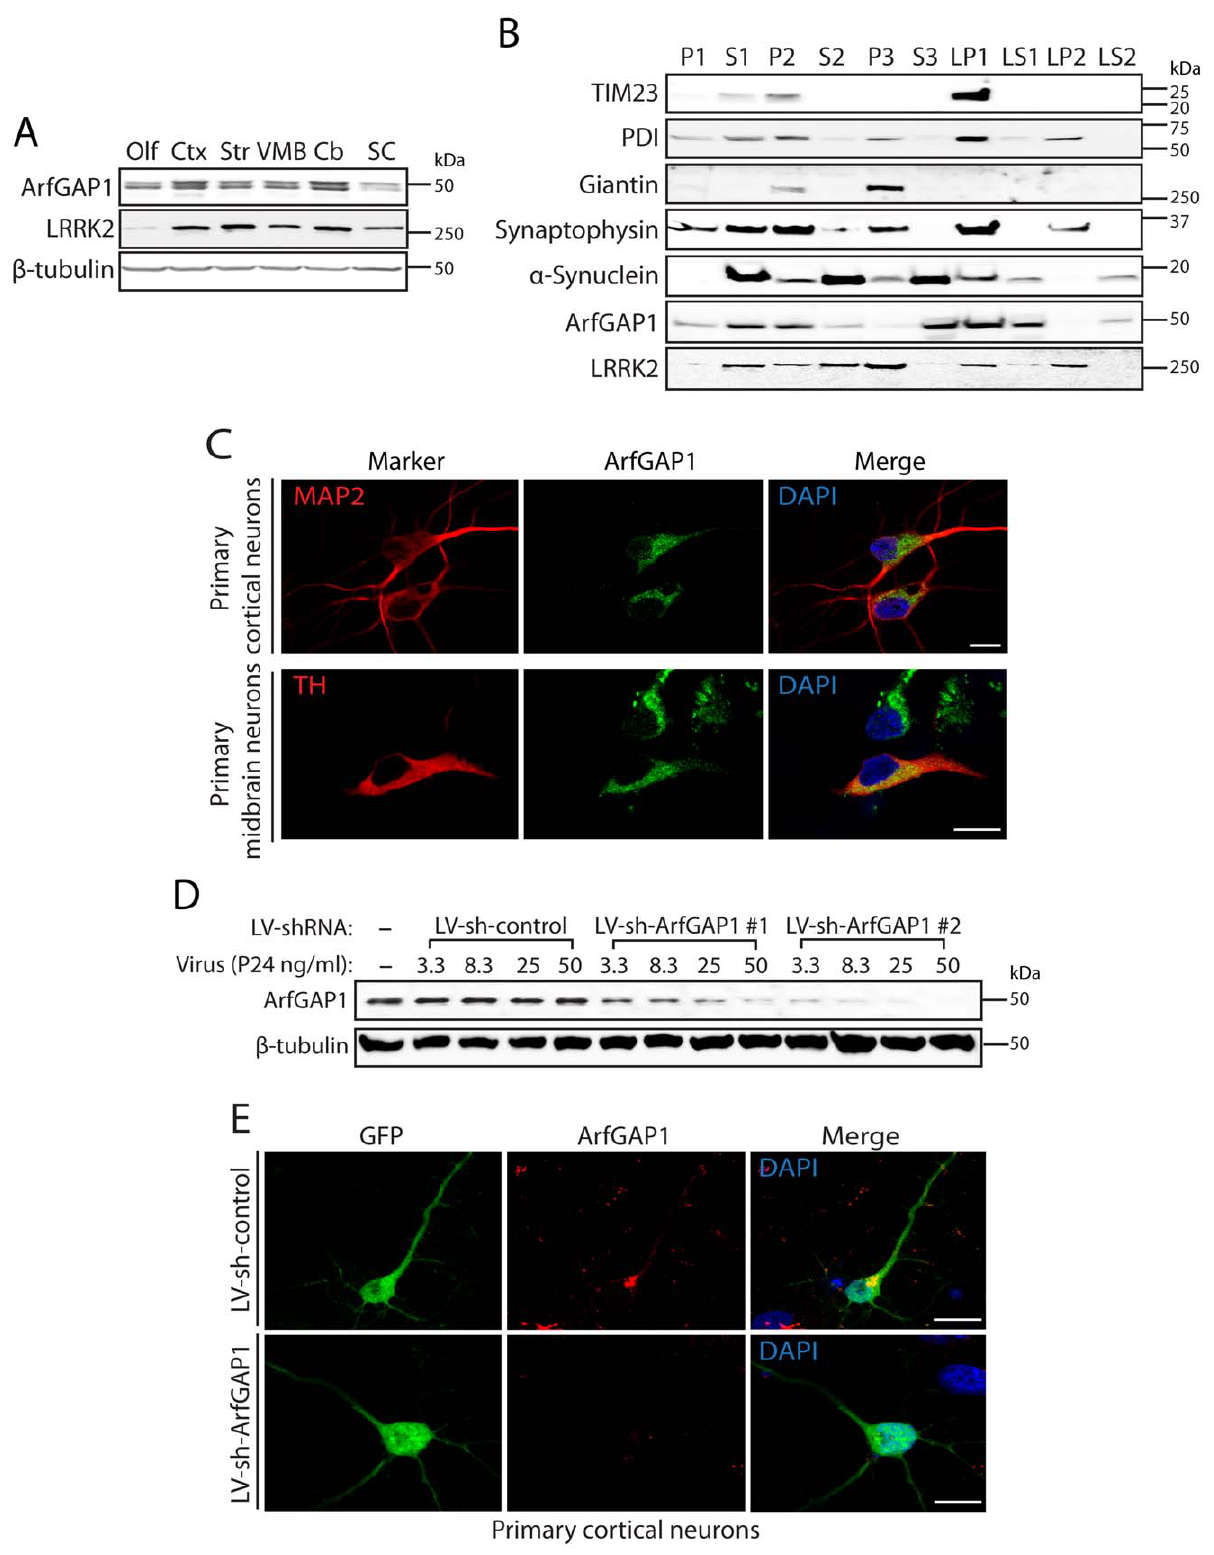
Figure 5. ArfGAP1 is expressed in the mammalian brain. (A) Western blot analysis of ArfGAP1 protein levels in mouse brain, with highest levels detected in cerebral cortex ( Ctx ) and cerebellum ( Cb ), moderate levels in striatum ( Str ) and ventral midbrain ( VMB ), and lowest levels in olfactory bulb ( Olf ) and spinal cord ( SC ). LRRK2 is detected at highest levels in striatum, cortex and cerebellum. b -tubulin indicates equivalent protein loading. (B) Subcellular fractionation of mouse whole brain tissue. ArfGAP1 is broadly detected with particular enrichment in membrane-associated fractions including the heavy (P2) and synaptosomal (LP1) membrane fractions, and soluble cytosolic (S1 and S3) and synaptosomal cytosolic (LS1) fractions.